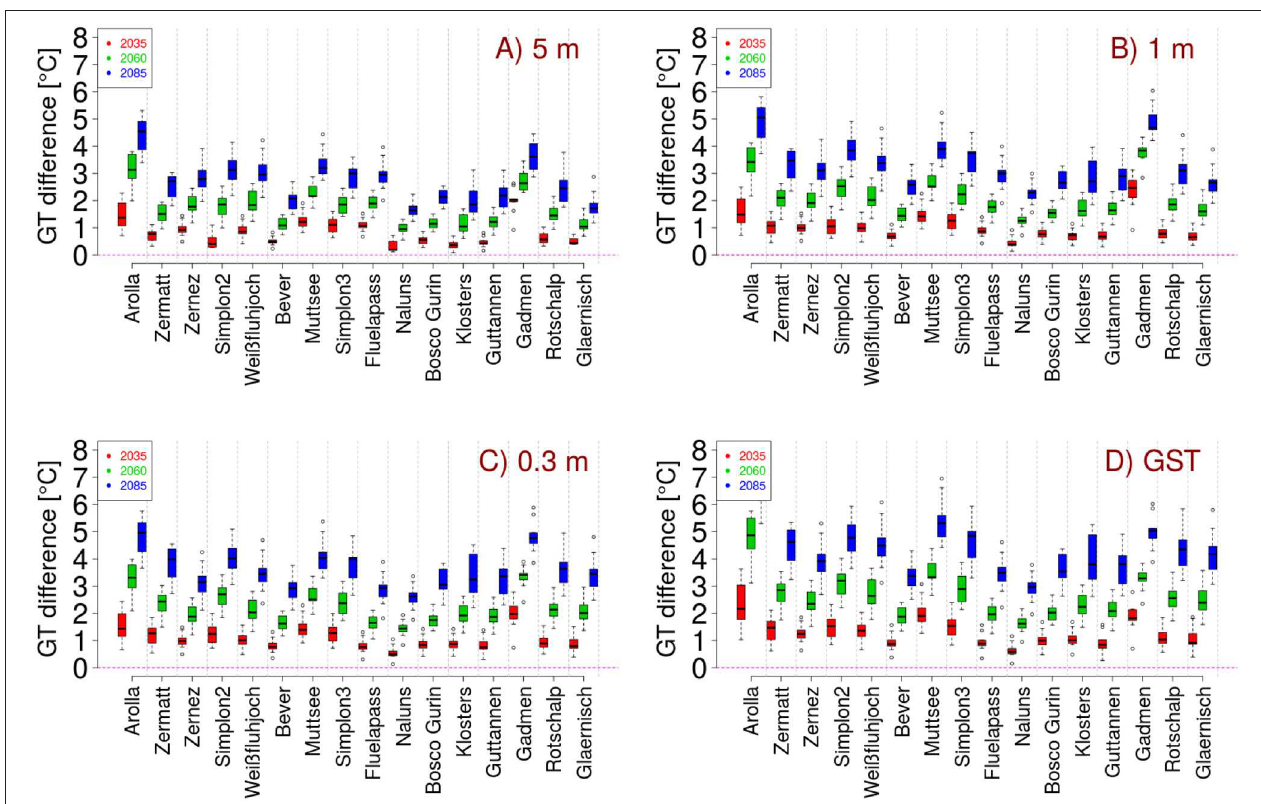
FIGURE 5 | Increase of ground temperature (GT) at surface (D) , 0.3m (C) , 1.0m (B) and 5.0m (A) depth, for all stations and all period is shown. Stations are ranked high to low and colors indicate climate change period. For all stations three boxes are shown. Ground temperature difference are shown in comparison to the reference period. The boxes show the differences between the 10 different regional climate change